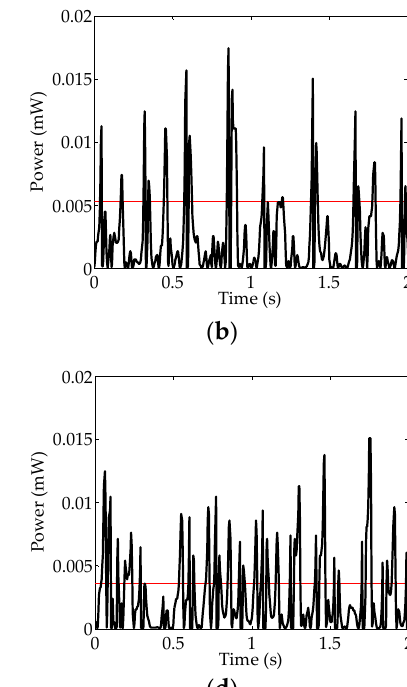
Figure 18. Power generation corresponding to different speeds: ( a ) 10 km/h; ( b ) 20 km/h; ( c ) 30 km/h; ( d ) 40 km/h.